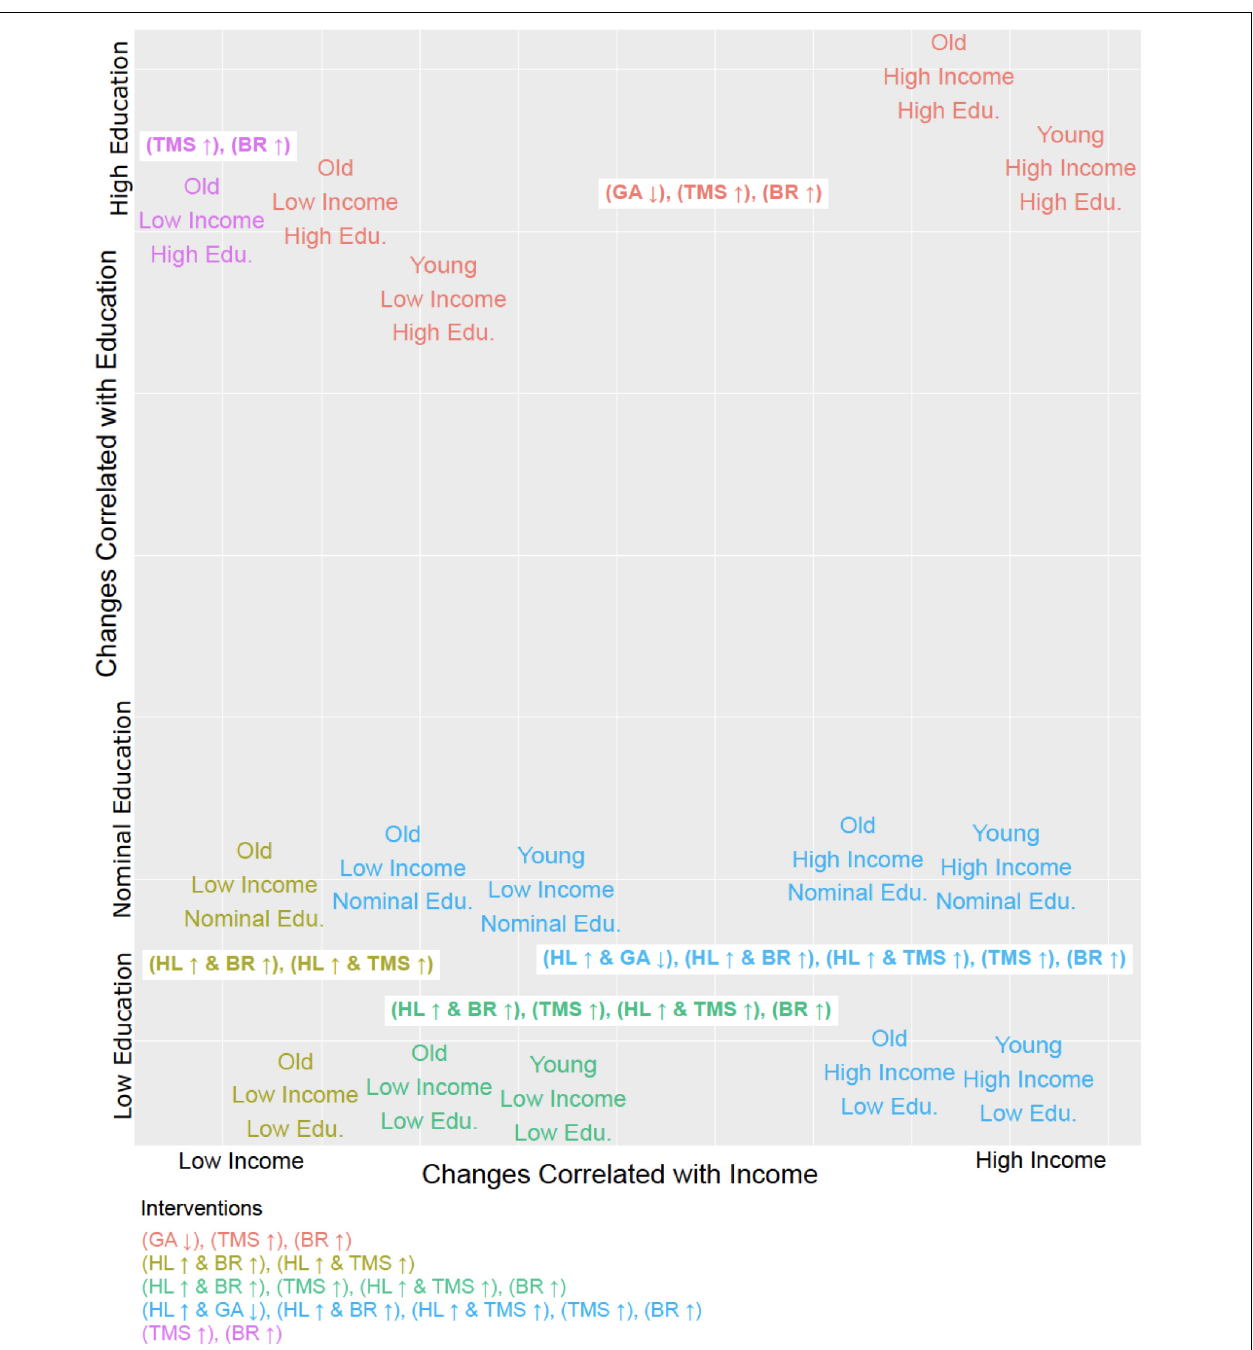
FIGURE 2 | Tailoring interventions to demographic profiles. Each of the 15 steady states identified in terms of its corresponding demographic profile (i.e., Young, High Income, Low Education would be Age = 0, Household Income = 0, Education = 0) plotted in relation to the six distinct intervention strategies (MIS, minimal intervention sets) and it’s effective in treating that group. The MIS abbreviations are as follows: General Anxiety (GA), Health Literacy (HL), Beneficial Behavioral Routine (BR), and Trust in Physician (TMS). The arrow next to the abbreviation indicates whether the entity is up or downregulated. All intervention strategies described by these MIS suffice to restore and maintain